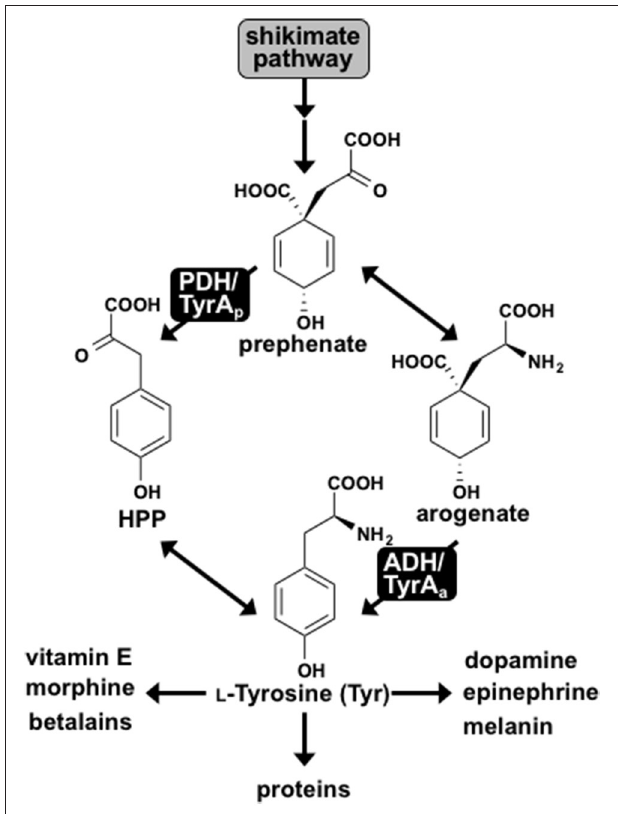
FIGURE 1 | L-Tyrosine biosynthesis via two pathways in plants and microbes. Two pathways for Tyr biosynthesis from prephenate downstream of the shikimate pathway are shown. The PDH/TyrA p pathway is present in most microbes, whereas the ADH/TyrA a pathway is ubiquitous in plants. Tyr serves as the precursor for protein synthesis and many downstream metabolites in plants and